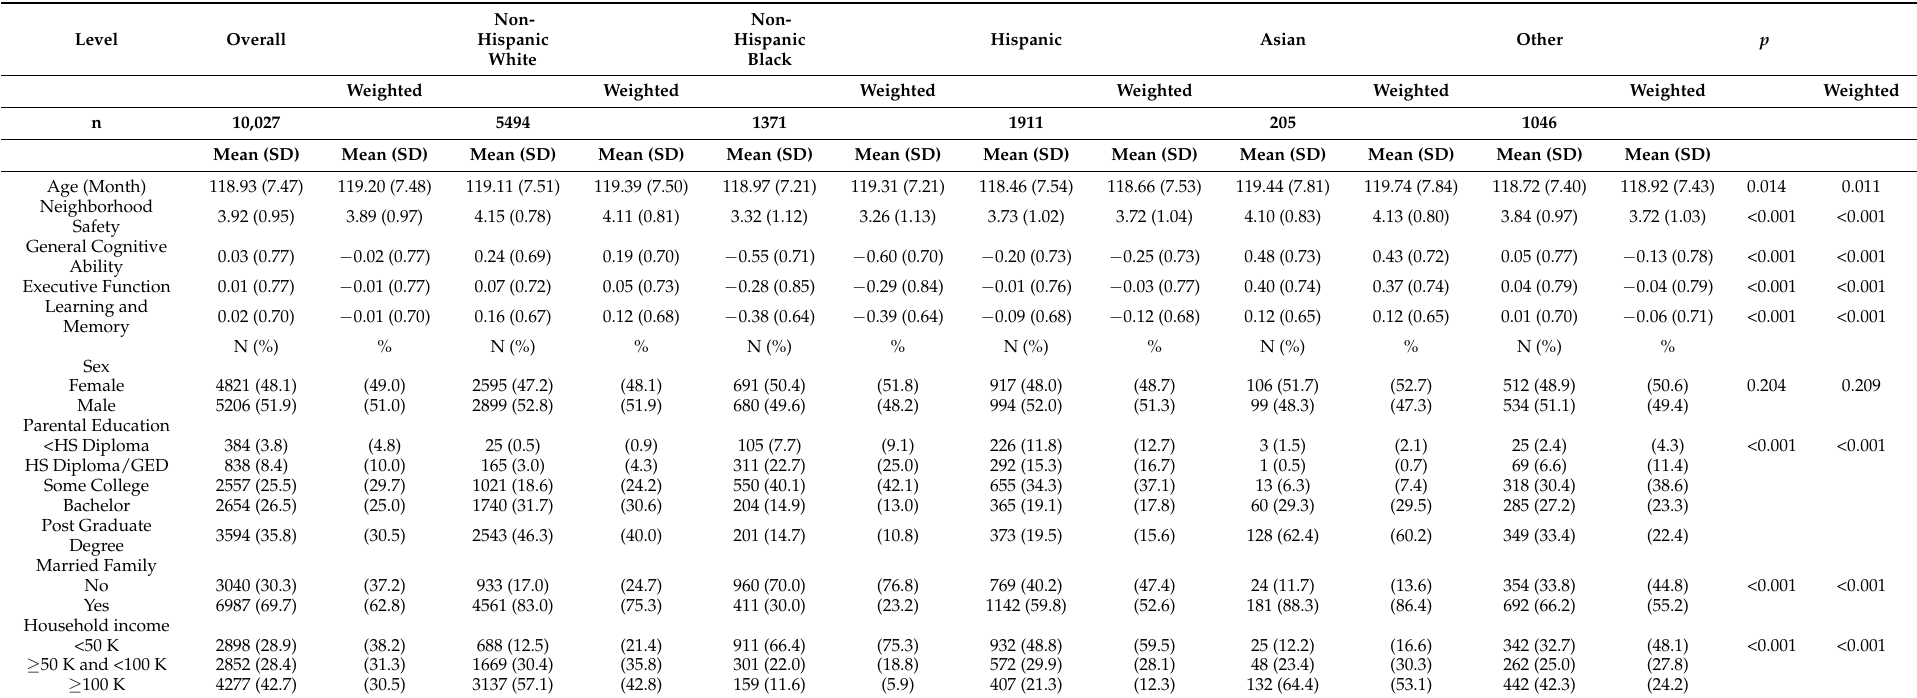
Table 1. Descriptive data overall and by